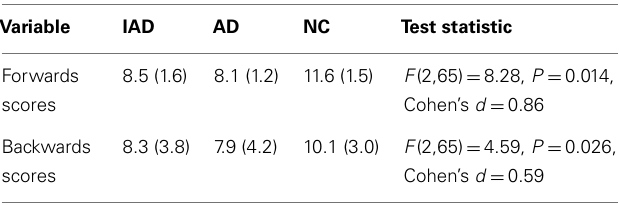
Table 5 | Digit span scores [mean (SD)] in IAD group ( n = 22),AD group ( n = 22), and NC group ( n = 22)